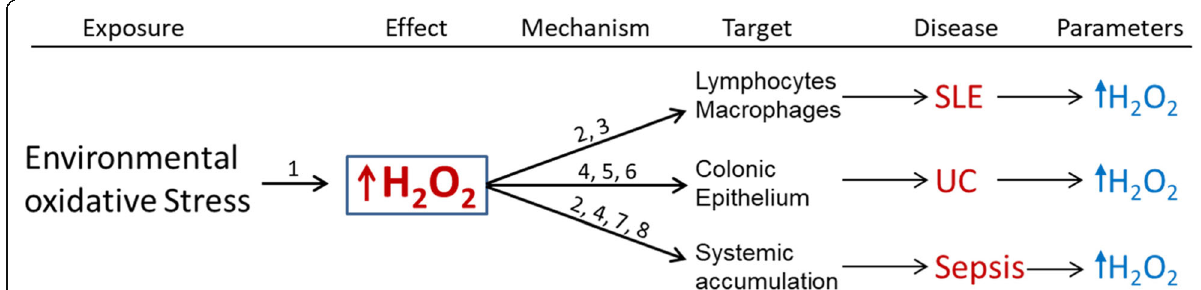
Fig. 1 Hydrogen peroxide and disease: A unified mechanism of pathogenesis. Environmental oxidative stress (infections, stress, xenobiotics etc.) leads to increased cellular hydrogen peroxide (H 2 O 2 ). Significantly elevated levels of H 2 O 2 have been documented in the colonic mucosa of patients with ulcerative colitis prior to the appearance of colitis, and toxic levels of H 2 O 2 have been reported in blood of patients with sepsis. Cumulative evidence also supports a casual role for excess lymphocyte and macrophage H 2 O 2 in the pathogenesis of systemic lupus erythematosus. H 2 O 2 has distinct properties that can lead to the development of each disease. They are: 1 ) increased by environmental oxidative stress exposure; 2 ) Potent apoptotic agent; 3 ) Impairment of phagocytosis; 4 ) Biomembrane permeability; 5 ) Chemotactic for neutrophils; 6 ) Oxidant induced intestinal barrier disruption; 7 ) Enzyme inhibition and 8 ) Hypotensive agent (Pravda 2005; Shenep et al. 1985; Pravda 2019a; Redza-Dutordoir and Averill-Bates 2016; Xiang et al. 2016; Oosting et al. 1990; Möller et al. 2019; Klyubin et al. 1996; Rao et al. 1997; Tatsumi and Kako 1993; Tretter and Adam-Vizi 2000) The resulting disease phenotype is a function of one or more properties of H 2 O 2 and the target cell in which H 2 O 2 accumulate; i.e., lymphocytes and macrophages in SLE, colonic epithelium in ulcerative colitis and systemic accumulation in sepsis. The capacity of cellular H 2 O 2 to increase in response to environmental oxidative stressors is critical to disease development. Determination of specific cell target and subsequent disease phenotype is dependent upon environmental oxidant stress exposure and differential tissue reductive (H 2 O 2 neutralizing) capacity influenced by genetic or epigenetic